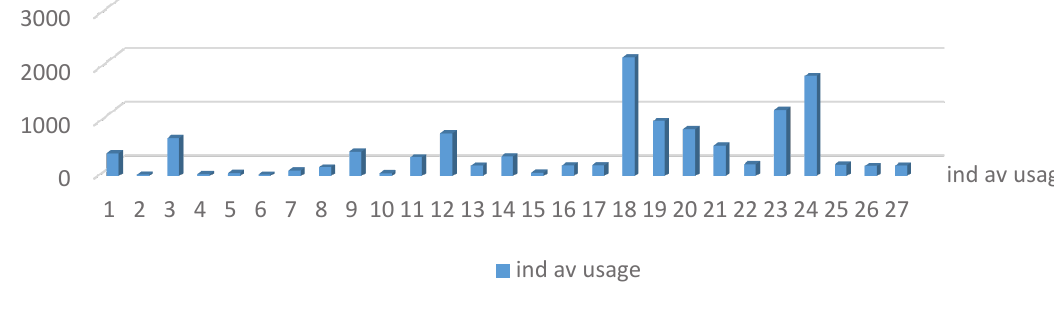
Figure 4. Individual country’s average financial service usage